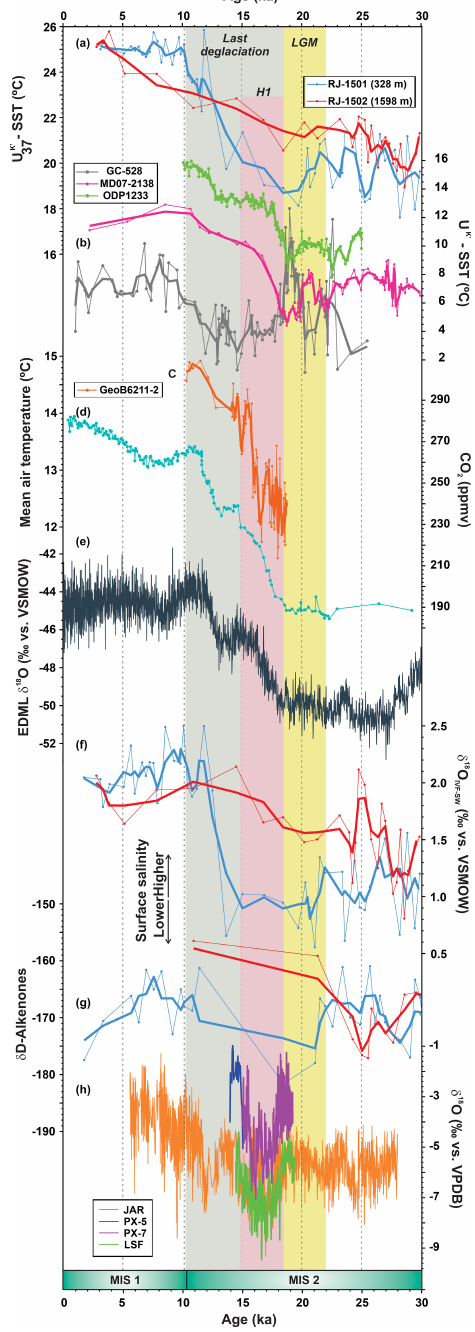
Figure 5. Comparison of the marine sediment cores RJ-1501 (blue) and RJ-1502 (red) with other Southern Hemisphere records. (a) Alkenone (cid:48) (cid:48) (U K )-derived sea surface temperature (SST) from cores RJ-1502 and RJ-1501. (b) U K -derived SST from ODP Site 1233 (green; Lamy et 37 37 al., 2007), MD07-2138 (purple; Caniupán et al., 2011), and GC528 (grey; Roberts et al., 2017). (c) Mean air temperature from GeoB6211- 2 (Chiessi et al., 2015). (d) Carbon dioxide (CO 2 ) concentration from Antarctic EPICA Dome C (Lüthi et al., 2008) on the Antarctic Ice Core Chronology (AICC2012) (Veres et al., 2013; Bazin et al., 2013). (e) Antarctic oxygen isotope from EDML (EPICA community members, 2004) on the AICC2012 chronology. (f) Ice-volume free seawater oxygen isotope ( δ 18 O IVF − SW ) from RJ-1501 and RJ-1502. (g) δ D-Alkenones from RJ-1501 and RJ-1502. (h) Speleothem oxygen isotope from Jaraguá cave (JAR) (Novello et al., 2017) and Paixão (PX-5 and PX-7) and Lapa Sem Fim (LSF) caves (Stríkis et al., 2015). Records are depicted by the original data (dots and thin line) and the respective three-point running average (thick line). Yellow, red, and grey bars denote the Last Glacial Maximum (LGM), Heinrich stadial 1, and last deglaciation, respectively. Marine isotope stages (MIS) are indicated at the bottom of the